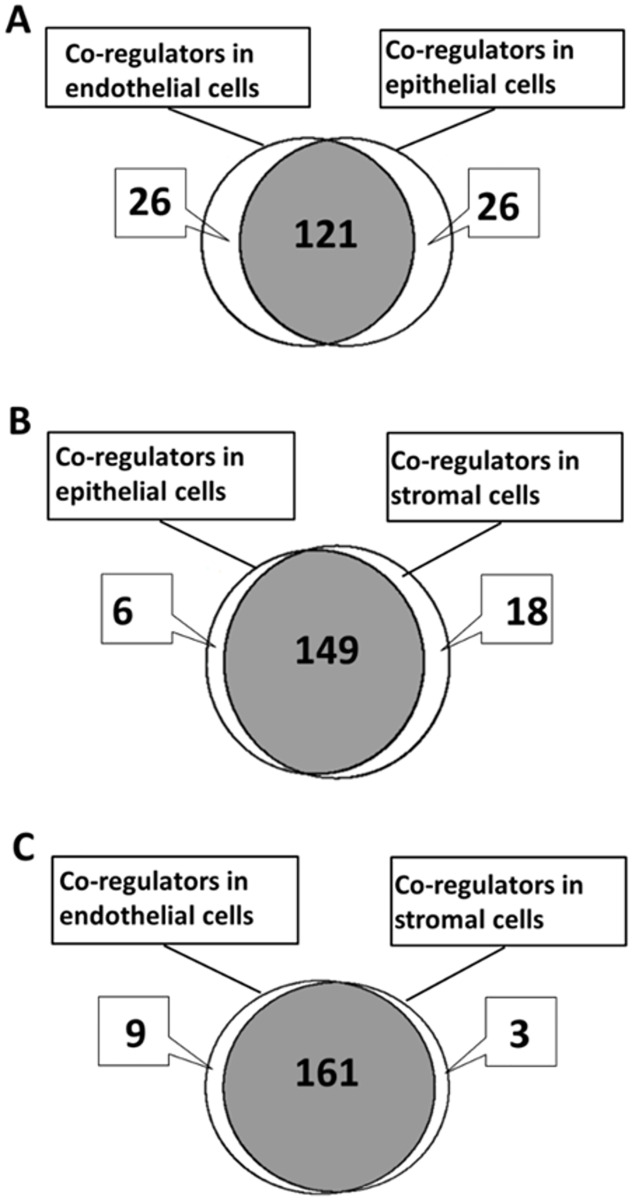
AR co-regulator expression.Venn diagram of differential expression of 173 AR co-regulator genes between endothelial cells vs epithelial cells (A), epithelial cells vs stromal cells (B), and endothelial cells vs stromal cells (C).